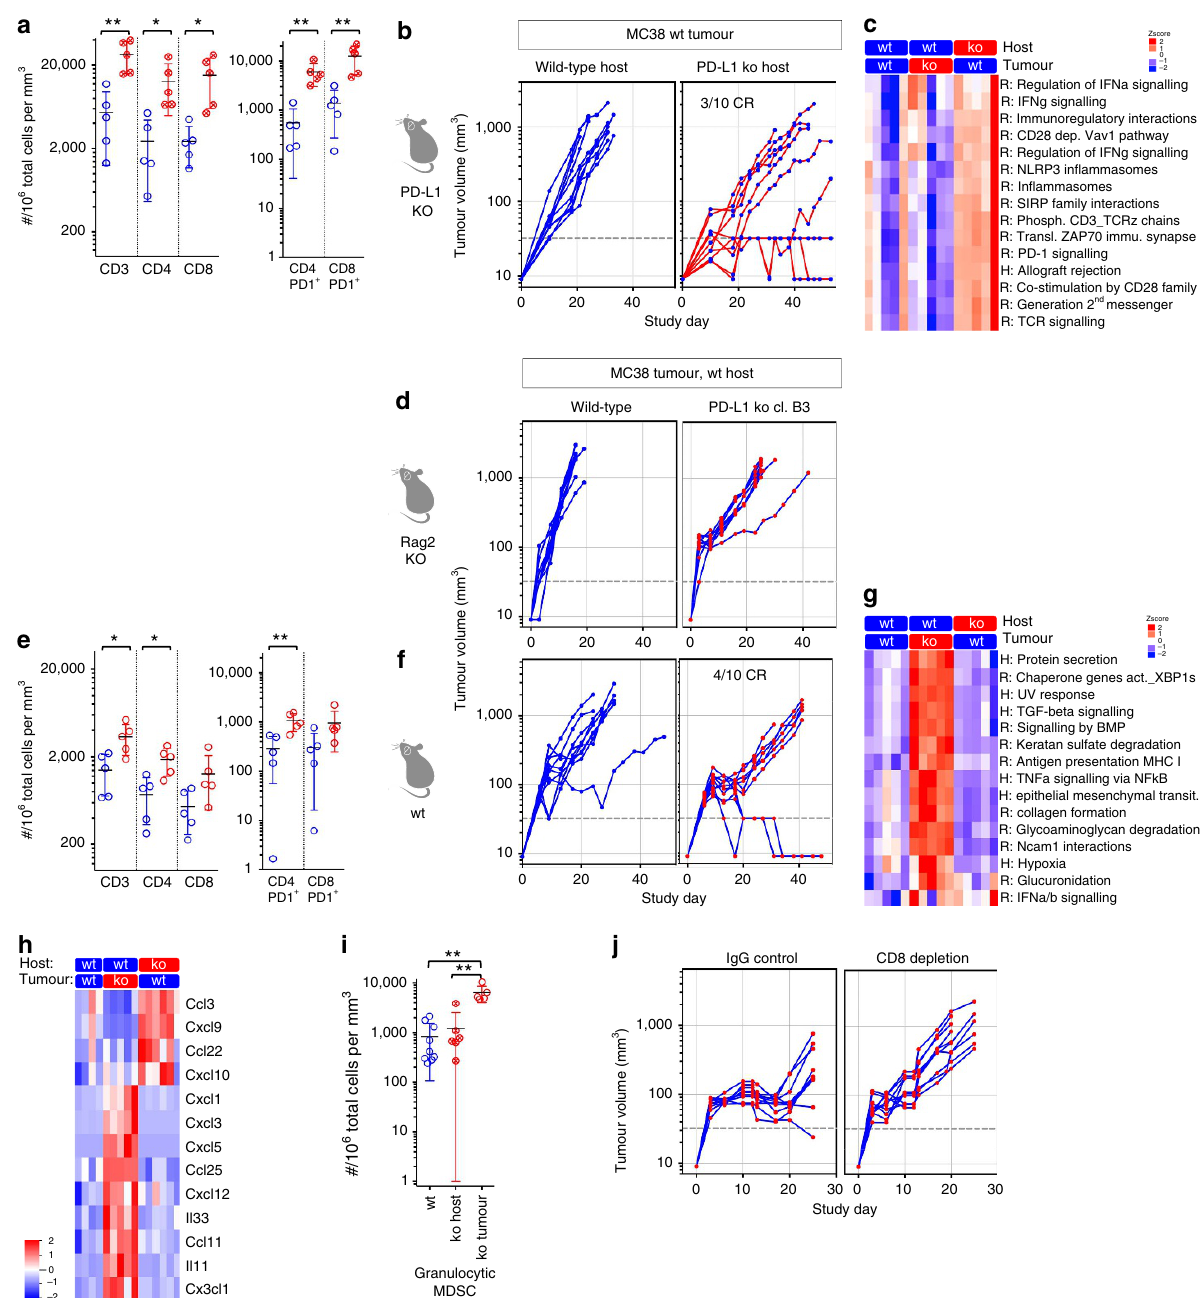
Figure 2 | Genetic deletion of PD-L1 results in T-cell activation and tumor regression. Flow cytometry analysis of PD-L1-deficient hosts showed increased T-cell infiltration and PD-1 expression in MC-38 tumours ( a ) and reduced tumour growth rate and complete tumour regressions (CR) were observed in 3/10 PD-L1-deficient mice ( b ). Most significantly upregulated gene sets were indicative of strong T-cell activation in MC38 wt tumor grown in PD-L1- deficient hosts ( c ). Similarly, wild-type (wt) mice inoculated with PD-L1-deficient MC-38 tumour cells showed increased activated, T-cell infiltration by flow cytometry ( e ). While PD-L1-deficient MC38 tumour cell inoculated into immune-deficient Rag2 KO mice showed normal tumour outgrowth ( d ), inoculation into wt mice leads to complete regression (CR) in 4/10 mice ( f ). Most significantly up-regulated gene sets were distinct and included stromal remodelling mechanisms ( g ). Significantly modulated chemokine gene expression was distinct between the host versus tumour PD-L1-deficient setting ( h ). Concordantly with the chemokine changes, increased numbers of granulocytic myeloid derived suppressor cells (MDSC) were detected in PD-L1-deficient tumours by flow cytometry ( i ). Depleting cytolytic CD8 þ populations alleviated PD-L1-deficient tumour regression ( j ). Characterization of immune subsets by flow cytometry in tumours was performed between day 14–21 post inoculation. Tumour samples for RNA analysis were collected at d9 post inocculation. RNA and flow cytometry data shown is from wt MC-38 tumours in PD-L1-deficient host (crossed circles) or PD-L1-deficient MC-38 tumours in wt host (open circles), with PD-L1 wt status represented in blue and PD-L1 deficiency (ko) represented in red. For tumour growth curves, the symbol colour is representative of tumour cell PD-L1 status, the line colour for host PD-L1 status. Data are representative of a minimum of two independent study repeats. Statistical significance was determined by Student’s t -test (* P o 0.05; ** P o 0.01.) for individual RNA or protein analytes, by CAMERA FDR P o 0.05 for gene set enrichment analysis. Error bars depict s.d. from the mean. Mouse cartoon adapted from ref.